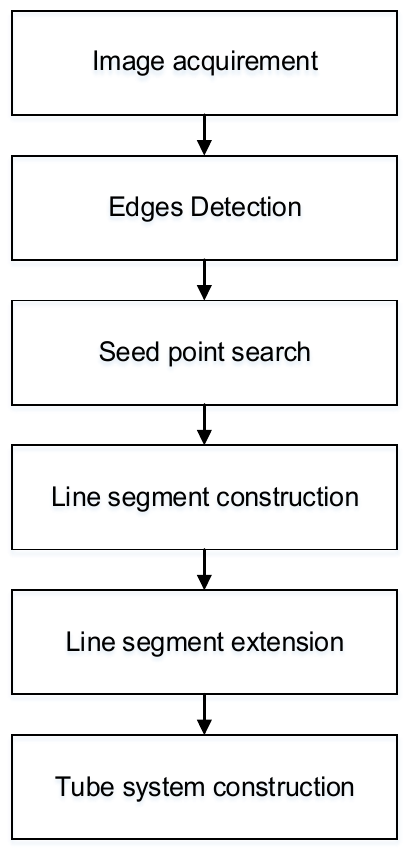
Figure 3. Scheme of tube